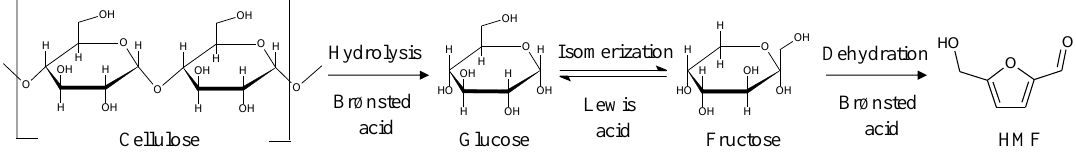
Figure 1. 5-hydroxymethylfurfural (HMF) production from cellulose.